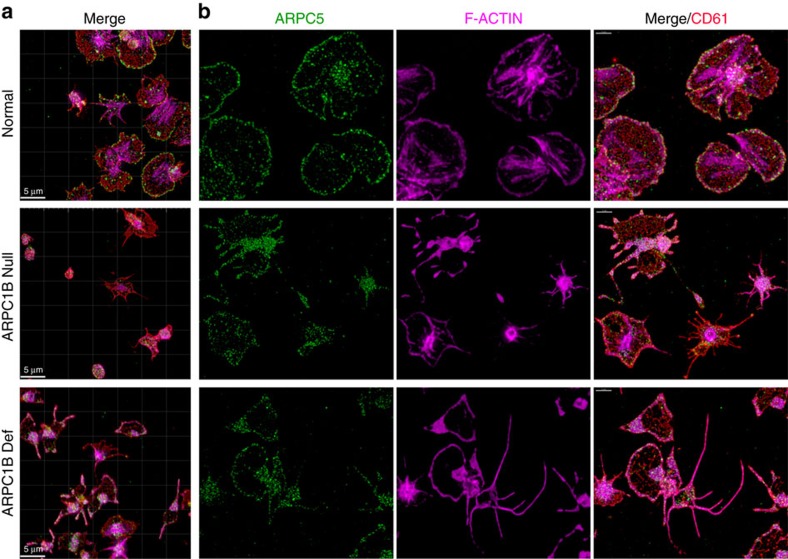
Spreading behaviour and distribution of ARPC5 and actin in normal and ARPC1B-deficient platelets.Platelets in platelet-rich plasma were allowed to spread on fibrinogen for 30 min before fixation, staining and imaging by laser fluorescence structured illumination microscopy. (a) Each set of panels shows a wide field image (bars=5 μm) and (b) higher magnification images of representative spread platelets stained for CD61/fibrinogen receptor (red), ARPC5 (green) and F-actin (magenta; bars=2 μm). Most normal platelets show circular lamellipodia, peripheral ARPC5 and F-actin present at the lamellipodial edge and in stress fibres and nodules (see also Fig. 6). In contrast, at his time point many ARPC1B-null platelets (from Patient 1) have not spread, or show abnormal shapes and subcellular distributions of ARPC5 and F-actin (note: close up panels are collages necessitated by the sparse distribution of spread platelets; all others are cropped fields). ARPC1B-deficient platelets (from Patient 2) also show limited spreading and unusual spread morphologies, including extremely long filopodia containing long unbranched actin fibres.